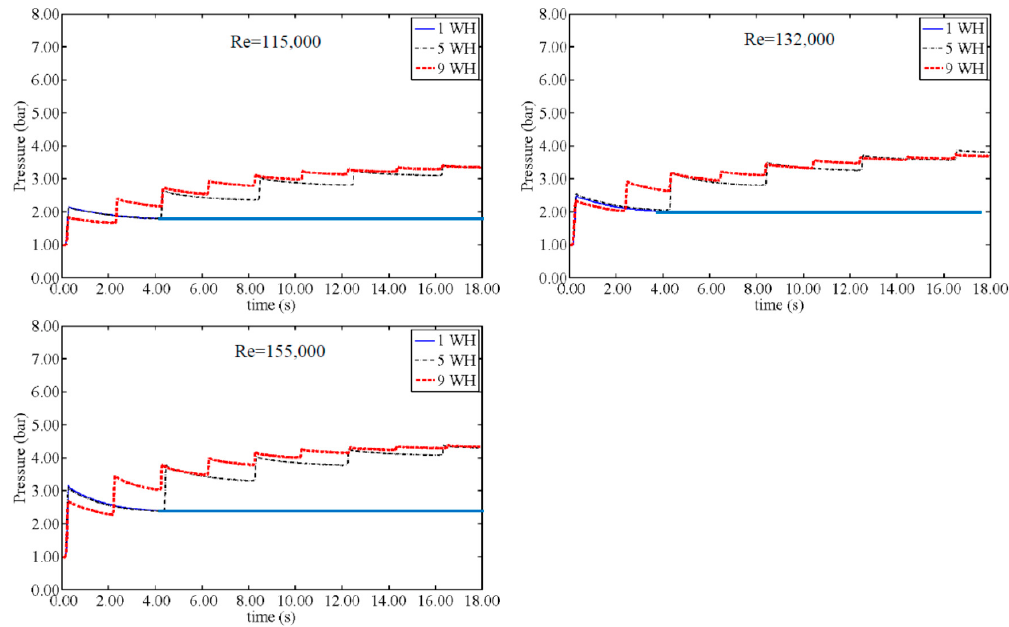
Figure 5. Pressure change in the AP for various WH events and Re for the VFR = 15.84%.